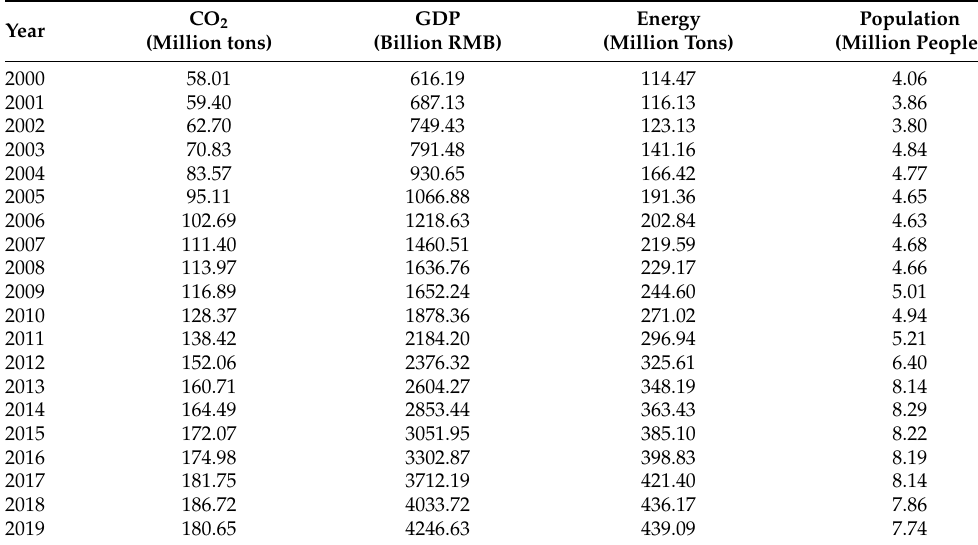
Table 3. Four absolute variables of carbon emissions in the logistics